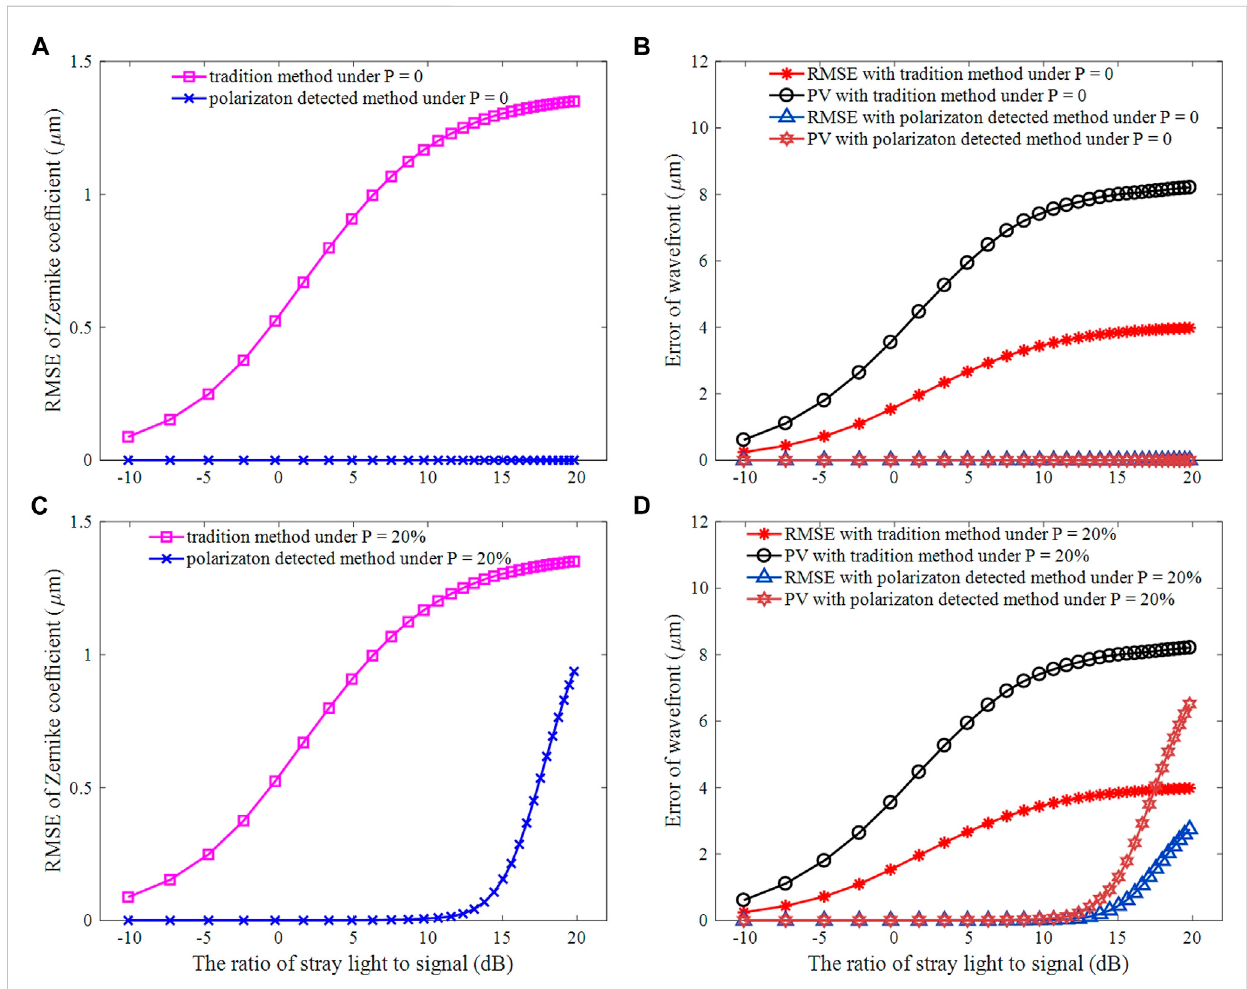
FIGURE 4 The error comparison between traditional method and p-SHWFS. Zernike coef fi cient error (A) and wavefront error (B) under the stray light with p = 0, Zernike coef fi cient error (C) and wavefront error (D) under the stray light with p = 20%.